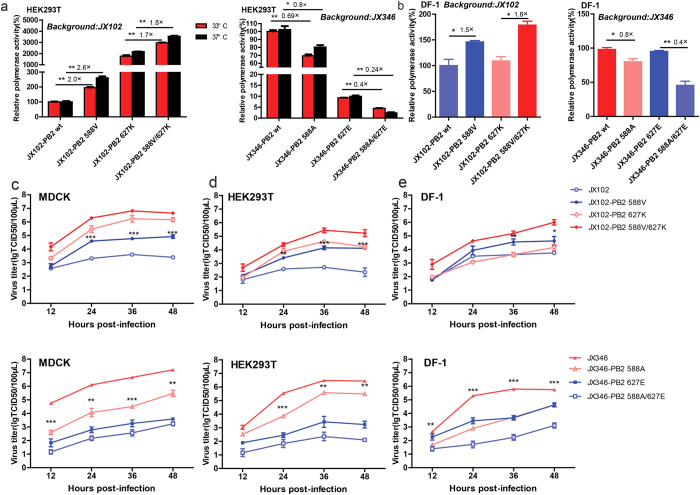
Polymerase activity and growth kinetics of JX102 or JX346 possessing different PB2 genotypes in human or avian cells.(a) HEK293T and (b) DF-1 cells were co-transfected with the RNP complexes composed of NP, PA, PB1 and wild type or mutant PB2 (single or double substitutions at position 588 and 627) of the JX102 or JX346 strain, together with a firefly luciferase reporter plasmid and Renilla luciferase reporter plasmid. Cells were incubated for 24 h at 37 °C, 33 °C (HEK293T) or 39 °C (DF-1). The polymerase activity of the wild type (JX346-wt and JX102-wt) was set to 100% and the data are presented as the mean luciferase activity from three independent experiments ± SD. Statistical significance was analyzed using an unpaired t test: *p < 0.05, **P < 0.01. (c–e) Growth kinetics of viruses: Confluent MDCK (c), HEK293T (d), and avian DF-1 (e) cells were infected with the indicated viruses at MOI of 0.01. Means of triplicate experiments are shown, with error bars representing the standard deviation. Statistical difference between the single PB2 588 mutant viruses compared with their respective parent viruses were labeled (*P < 0.05, **P < 0.01, ***P < 0.001)